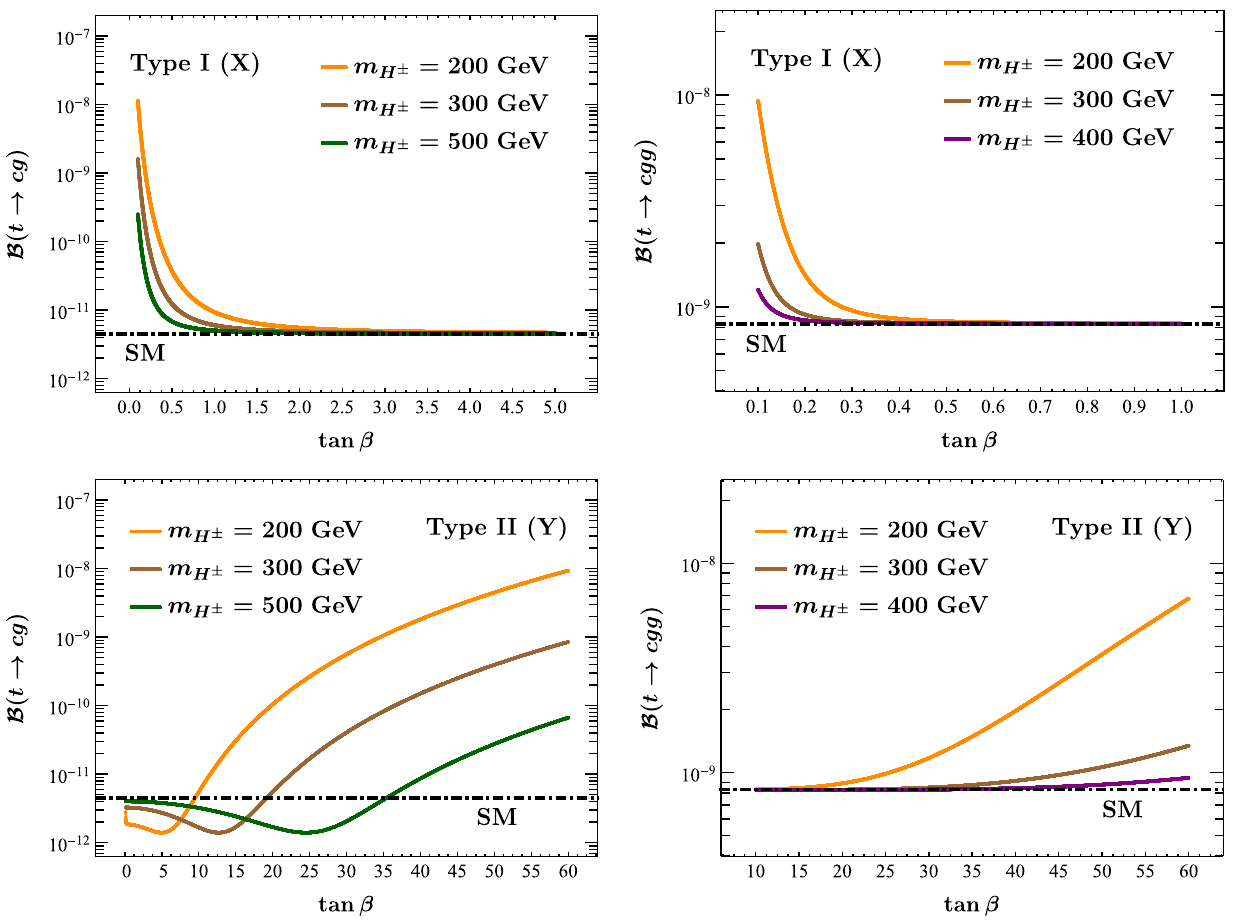
Fig. 6 The branching ratios of t → cg (left) and t → cgg (right) as a function of the parameter tan β = [ 0 . 1 , 60 ] , for three differ- ent choices of the charged-Higgs mass m H ± , in the four conventional 2HDMs with Z 2 symmetries. The horizontal dash-dotted lines repre- sent the SM predictions. We show only the ranges of tan β where the resulting branching ratios display significant enhancements compared